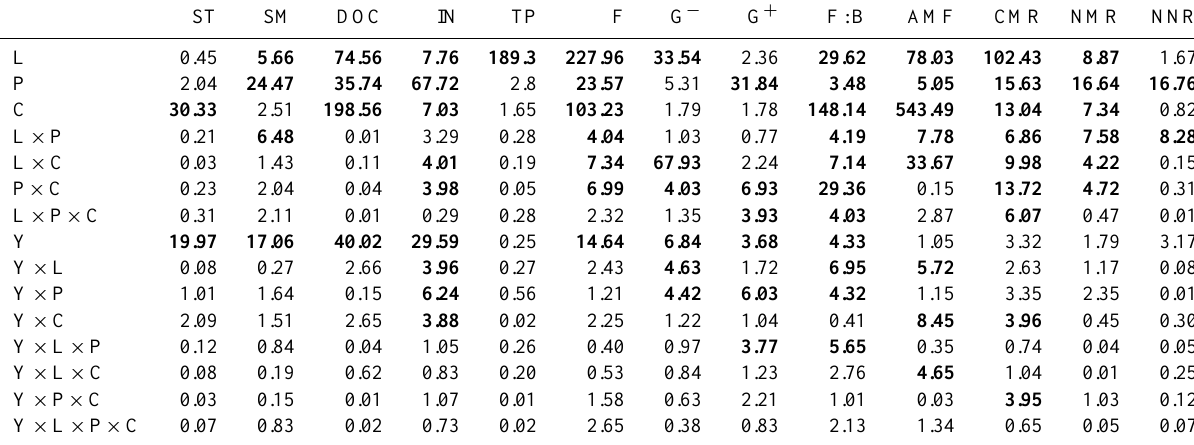
Table 2. Results ( F values) of repeated measures ANOVAs on the effects of belowground particulate litter addition (L), increased precipita- tion (P) clipping (C), and year (Y), and their interactions on soil temperature (ST) and moisture (SM), soil dissolved organic C (DOC) and inorganic N (IN), soil total PLFAs (TP), soil fungal PLFAs (F), gram-negative and gram-positive bacterial PLFAs (G − , G + ) , the ratio of fungal to bacterial PLFAs (F:B), arbuscular mycorrhizal fungi PLFAs (AMF), soil C mineralization rate (CMR), net N mineralization rate (NMR) and net nitrification rate (NNR).